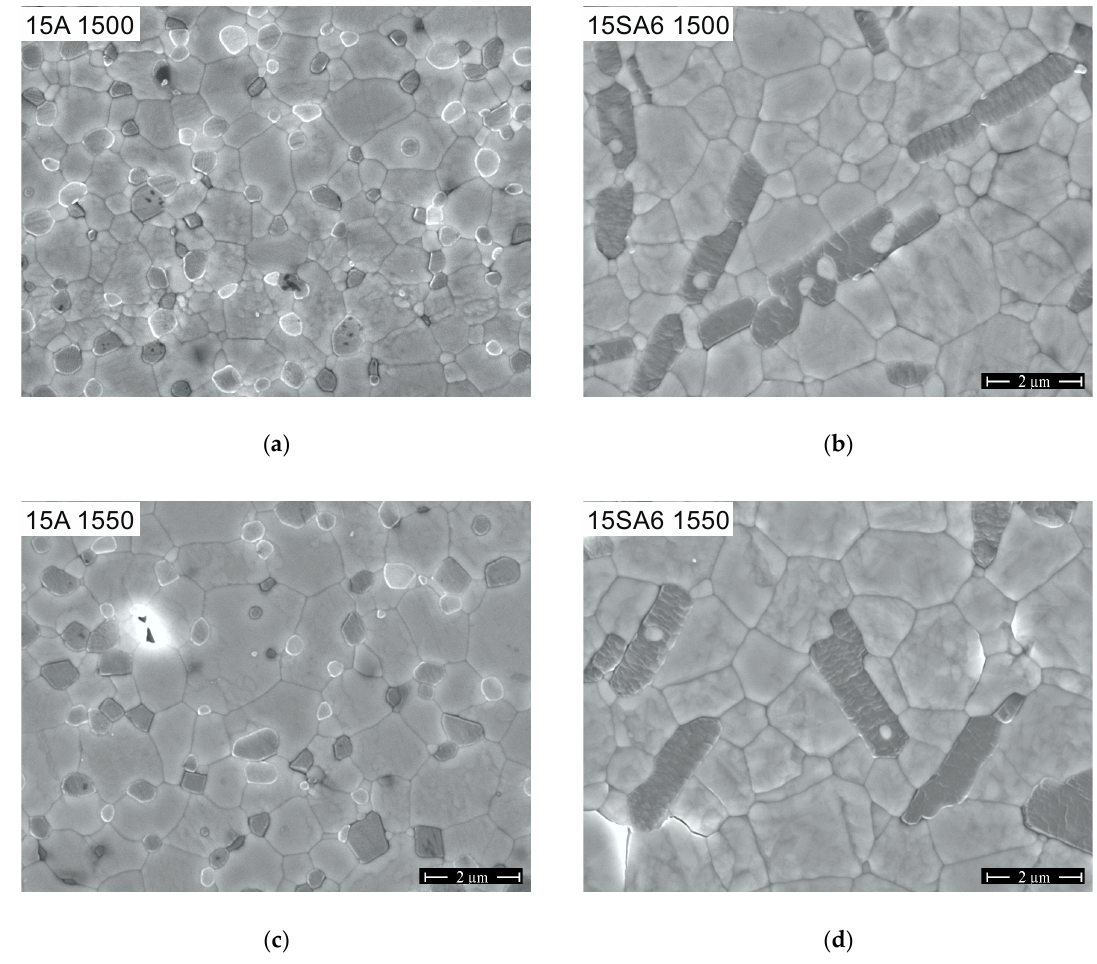
Figure 1. SEM images of polished and thermally etched surfaces of ( a ) 15A-1500, ( b ) 15SA6-1500, ( c ) 15A-1550, and ( d ) 15SA6-1550.